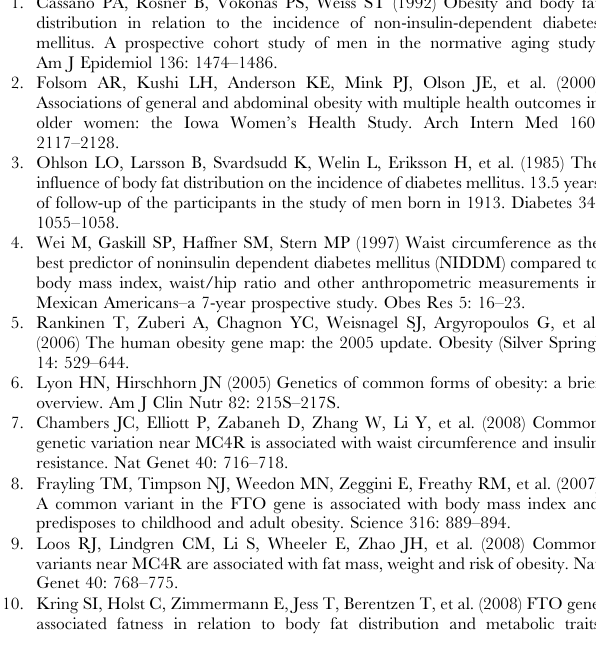
Table S4 Comprehensive results from the CHARGE consor- tium for body mass index with P , 9.9 6 10 2 6